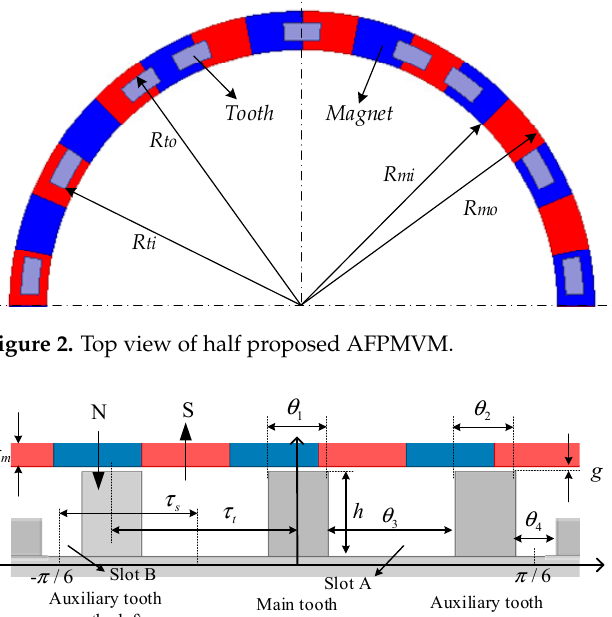
Figure 1. Configuration of the proposed AFPMVM: ( a ) regular topology ( b ) proposed topology.